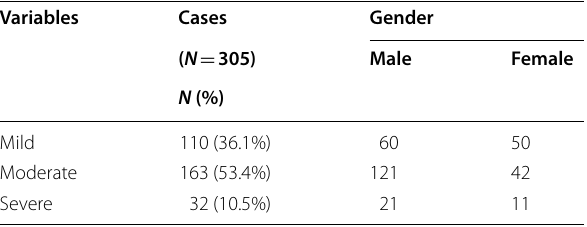
Table 3 CT severity score among the studied cases